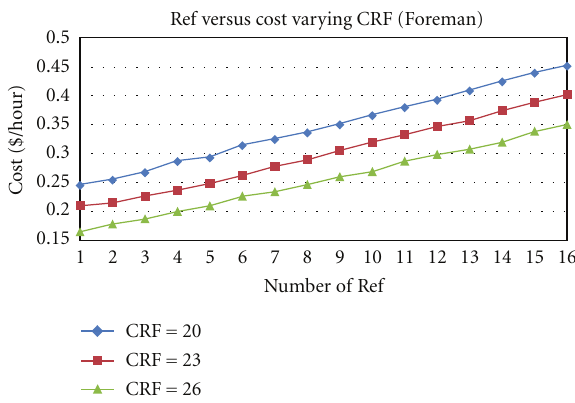
Figure 6: Averaged encoding cost for all videos.